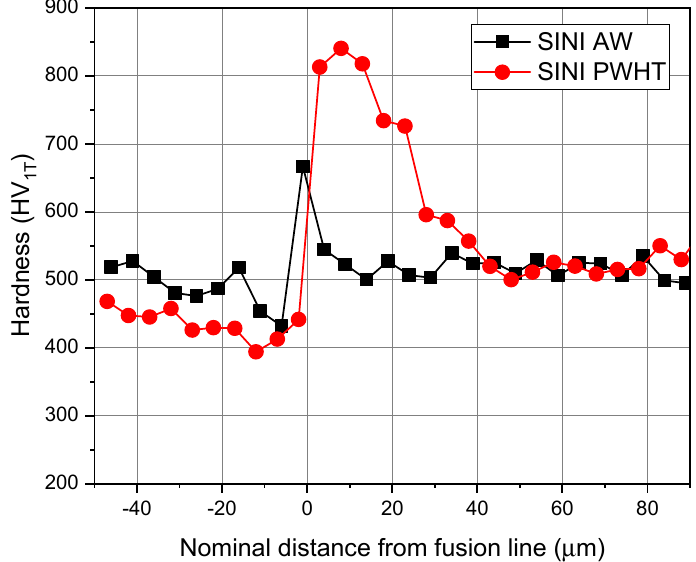
Figure 12. Comparison of the nanoindentation hardness profiles of SINI AW and SINI PWHT at the LAS/Alloy 52 weld metal interface.